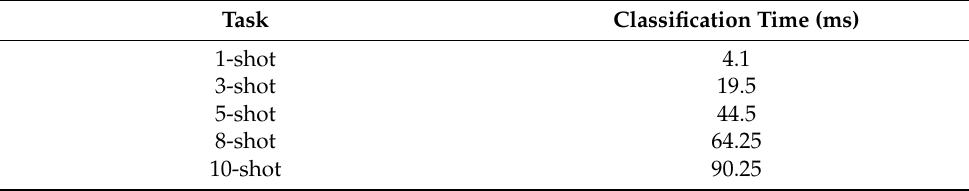
Figure 7. Distribution of similar scores between each health state. Table 4. Classification time for each sample under the different setting.